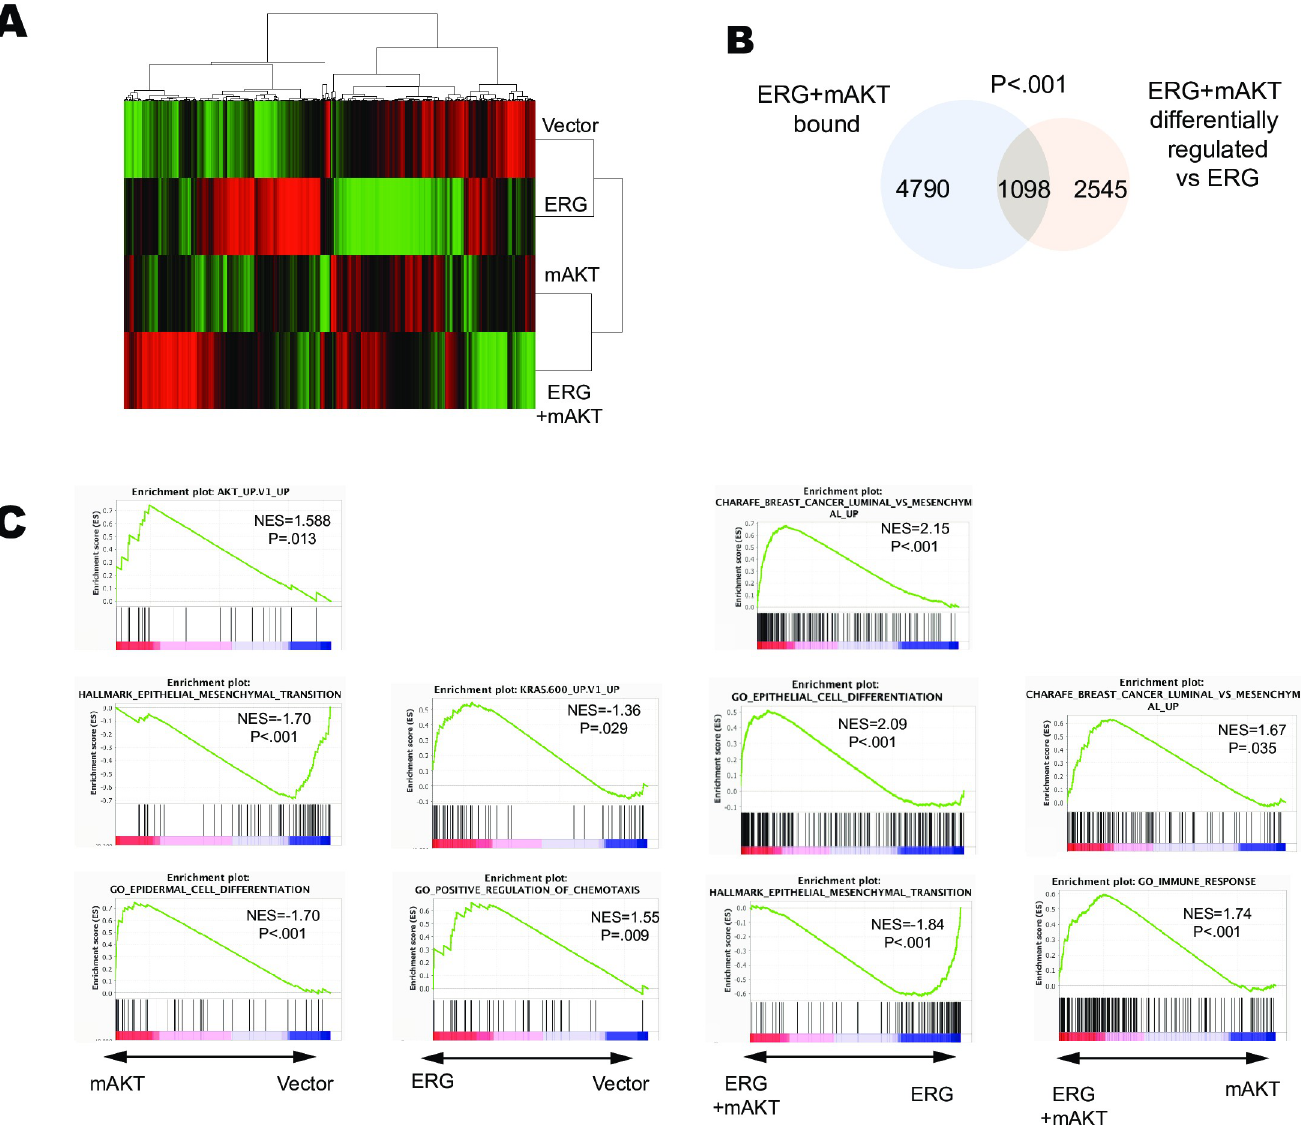
Fig 5. Constitutive PI3K/AKT signaling co-operates with ERG to promote luminal fate associated gene programs. (A) Unsupervised clustering of RNA-Sequencing data from RWPE1 cells expressing Vector, ERG, myr-AKT, or ERG+mAKT (green-activated, red-repressed) (B) Overlap of genes nearest ERG bound regions in RWPE-ERG/mAKT and significantly differentially regulated genes in RWPE-ERG/mAKT compared to RWPE/ERG (C) Top GSEA enrichments when comparing gene expression in the RWPE1 cells expressing the indicated constructs (below).